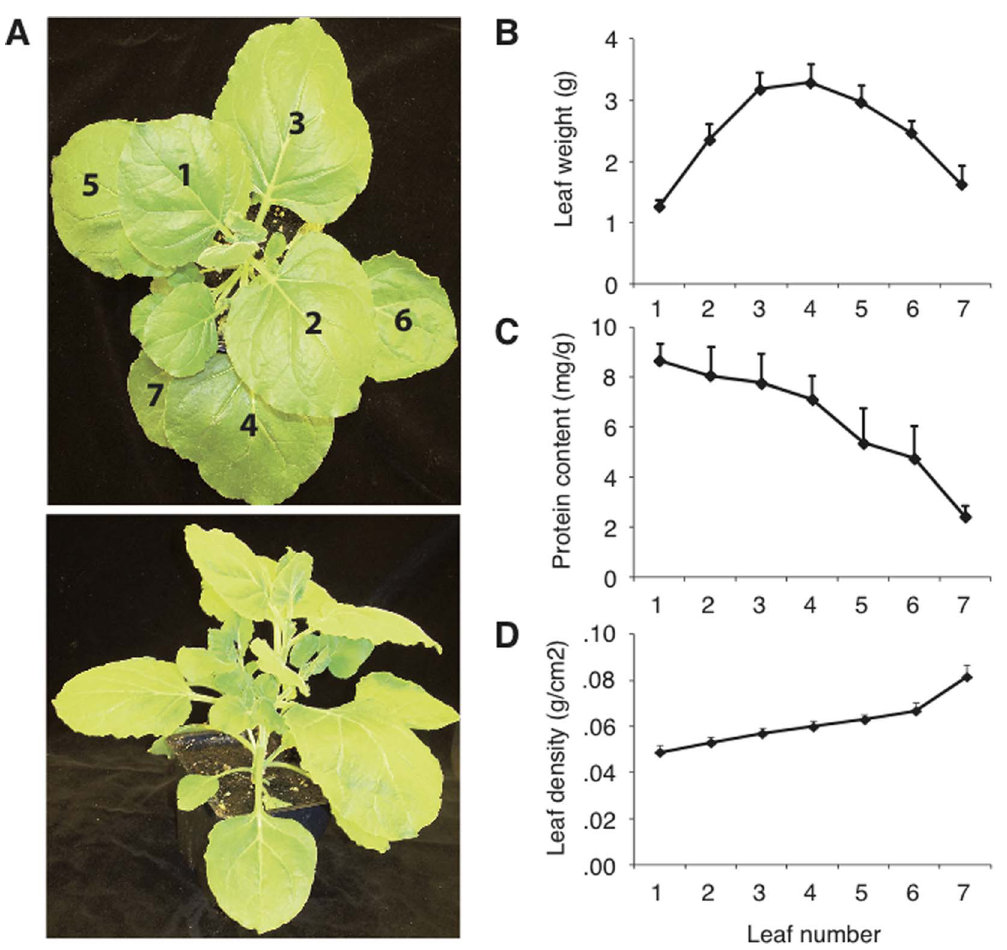
Figure 2. Characterisation of N.benthamiana leaf biomass. (A) Representative 49 days-old N. benthamiana plant (aerial and side views), with leaves numbered from the apex down. (B) Leaf weight given as a mean of eight measurements for each leaf position 6 SE. (C) Mean protein content in total extracts from three biological replicates 6 SE. (D) Leaf density calculated by dividing the weight of leaf discs by their area. Each point is the mean of three independent (biological replicate) values 6